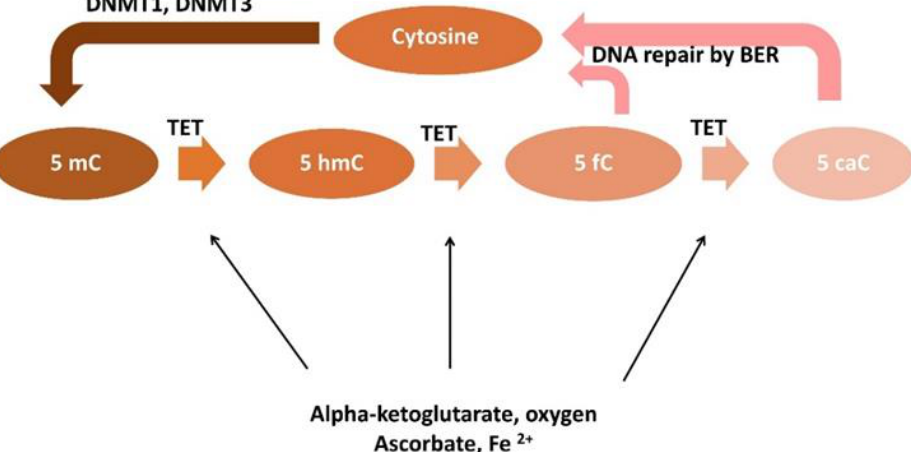
Figure 2. Cytosine transformations are catalyzed by the TET enzymes and their co-substrates (alpha- ketoglutarate, oxygen) and co-factors (ascorbate, Fe 2+ ). TET: Ten-Eleven Translocation enzymes; DNMT1,3: DNA methyltransferases; BER: Base Excision Repair; 5-mC:5-methylcytosine, 5-hmC: 5- hydroxymethylcytosine; 5fC: 5-formylcytosine; 5caC: 5-carboxylcytosine.